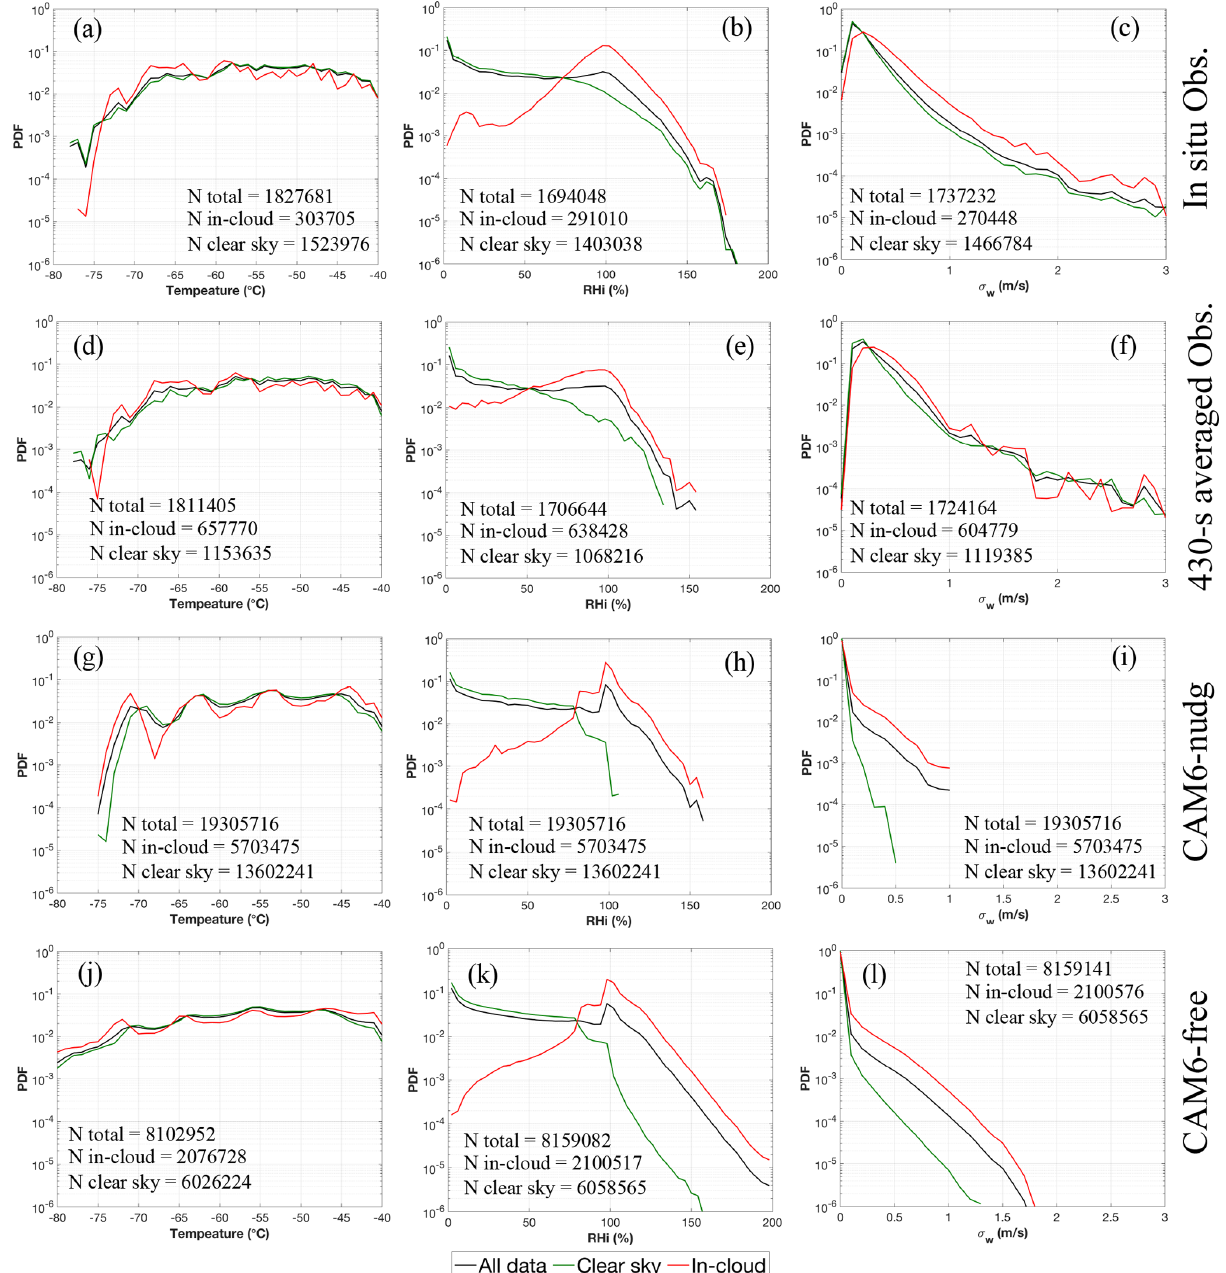
Figure 12. Probability density functions (PDFs) for (a, d, g, j) temperature, (b, e, h, k) RHi and (c, f, i, l) σ w , compared among (a–c) 1Hz observations, (d–f) 430s averaged observations, (g–i) CAM6-nudg and (j–l) CAM6-free data. Note that σ w in panel (c) is calculated for every